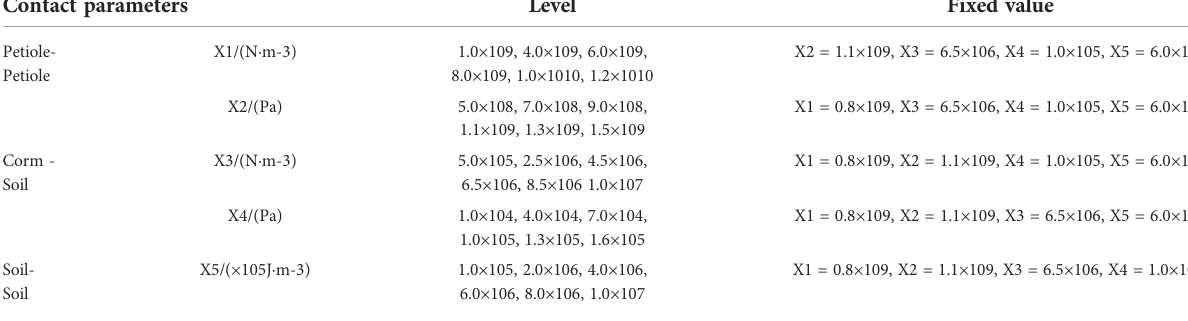
TABLE 4 Value range of single factor exposure parameters. Contact